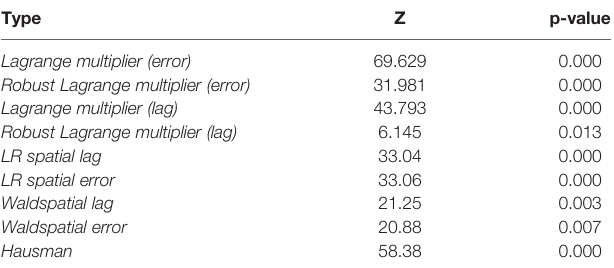
TABLE 7 | LM, Wald, LR and Hausman